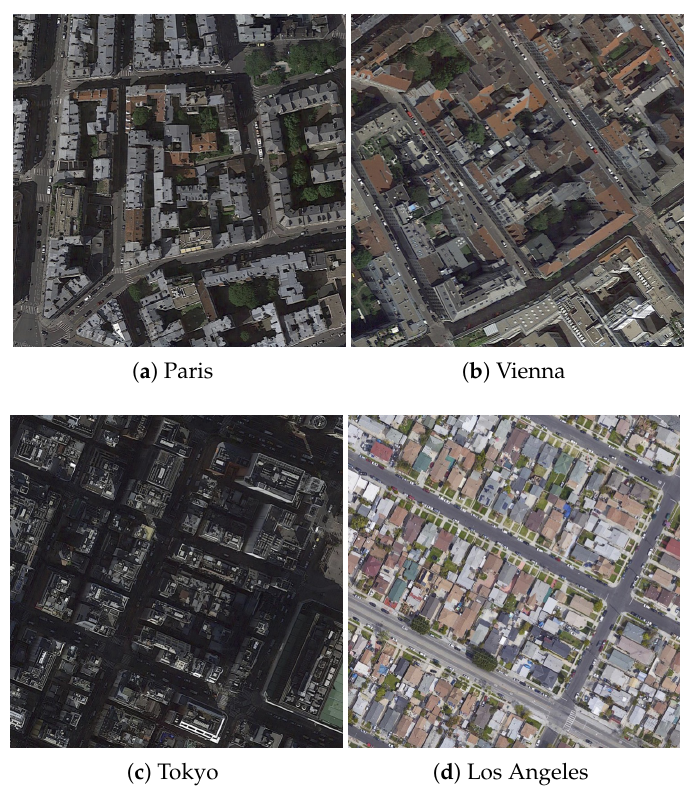
Figure 1. Images from the DREAM-B data set. The figures of ( a – d ) are sample images from the city of Paris, Vienna, Tokyo, and Los Angeles. All the samples are with a size of 800 × 800.